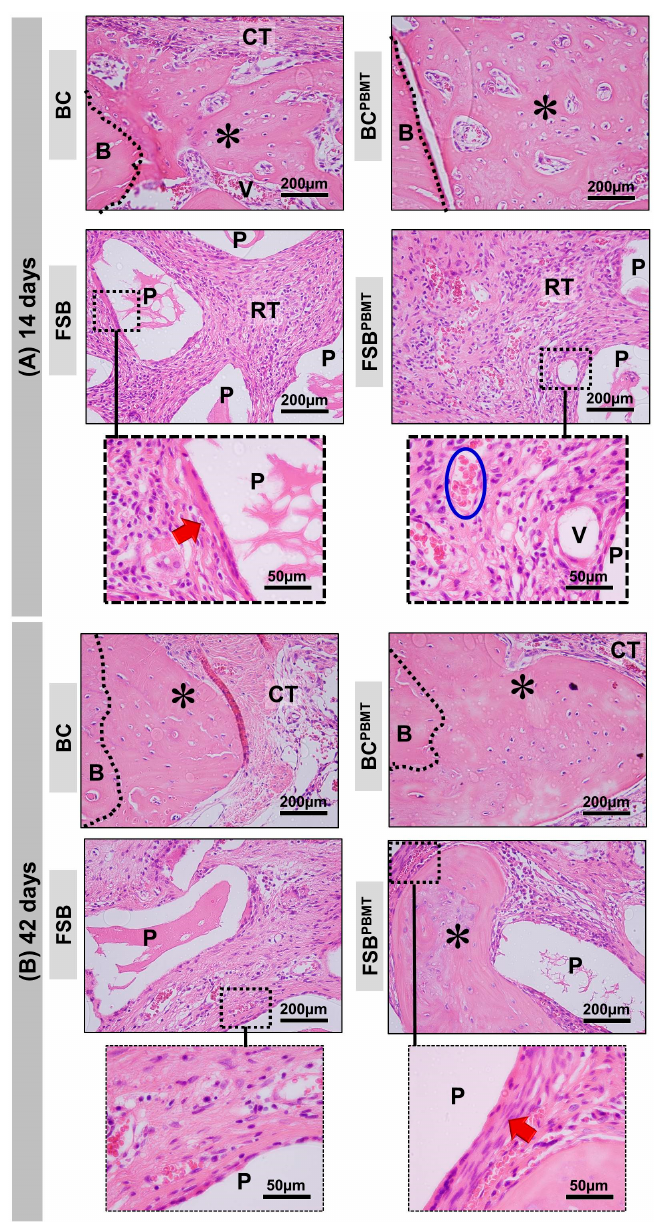
Figure 3. Details of the evolution of the bone healing of the skull defects filled with a blood clot or fibrin sealant plus xenograft (biomaterial) with or without low-level laser biostimulation therapy. ( A ) At 14 days, BC and BC PBMT : the defect shows the trabecular bone formation (asterisks) adjacent to the defect border and spaces between the trabeculae filled by connective tissue. FSB: the defect was filled by particles of the biomaterial (P) surrounded by connective tissue with some inflammatory cells (RT—reactional tissue). Collagen fibres surrounding the xenograft particles (red arrow). FSB PBMT : the defect was filled by particles of the biomaterial (P) surrounded by connective tissue with some inflammatory cells (RT—reactional tissue). Presence of many red blood cells (inside the blue lined area) and blood vessels (V) permeating connective tissue; ( B ) At 42 days, BC and BC PBMT : the new bone shows a gradual increase in thickness of the trabeculae leading to a compact structure. FSB: the new bone formation increases, becoming compact, there is a presence of xenograft particles and a decrease in inflammatory response. In FSB PBMT , the collagen fibres are arranged in more layers surrounding the particles. (HE; original magnification × 40; bar = 200 µ m; and Insets, magnified images × 100; bar = 50 µ